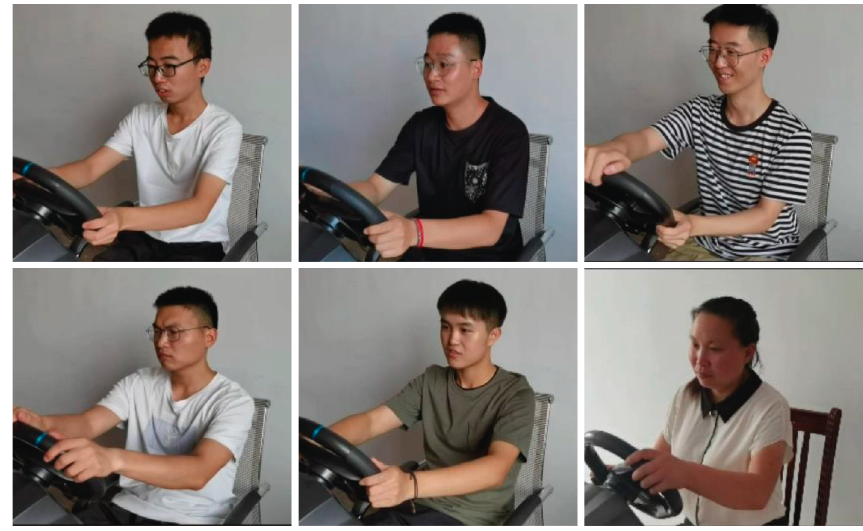
Figure 8: Samples of our data set.